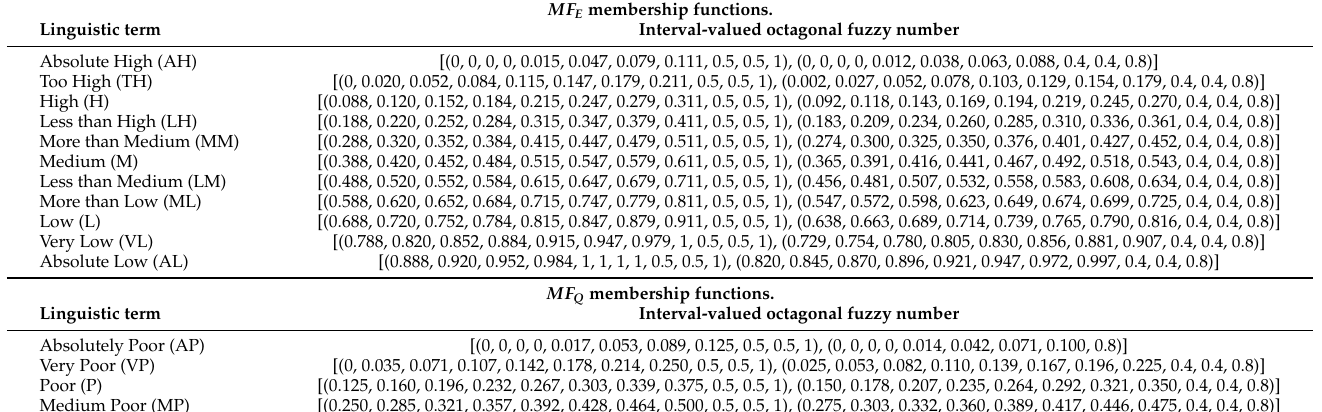
Table 1. Linguistic terms and the corresponding interval-valued octagonal fuzzy numbers used for MF E , MF Q and MF S . MF E membership functions. Linguistic